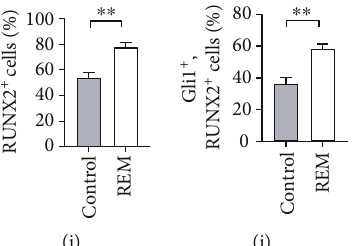
Figure 1: Gli1 + cells residing in palatal sutures involved in mechanical force-induced maxillofacial bone remodeling. (a) Experimental procedure: Gli1-LacZ mice were sacri fi ced seven days after rapid maxillary expansion (RME) treatment. Control mice were not subjected to RME and were sacri fi ced at the same time. (b) Coronal sections of maxillae of RME and control mice were stained with hematoxylin/eosin and Masson ’ s staining. Compared with that in the controls, maxillofacial sutures in RME mice were expanded, and cells residing on the nasal and oral sides of the suture had increased. Collagen in the suture was rearranged along the direction of the mechanical force. The area between two dotted lines shows the midpalatal suture. Scale bar: 100 μ m; n = 3 . (c) New bone formation was visualized using calcein; the distance between green fl uorescence lines indicates newly formed bone. Scale bar: 20 μ m; n = 3 . (d) New bone deposition rate was faster in the RME group, ∗∗∗ P < 0 : 005 ; n = 3 . (e) Micro-computed tomography (micro-CT) shows horizontal plane views of the maxillae. Scale bar: 2mm. The left panel shows magni fi ed sutures in the boxes. Scale bar: 0.5mm. (f) The distance between two fi rst molars was widen in RME mice. ∗ P < 0 : 05 ; n = 3 . (g) Immuno fl uorescence staining presents Gli1 (green) and RUNX2 (red) expression in the midpalatal suture areas of the RME group and control group. Scale bar: 100 μ m. Regions in boxes are magni fi ed in the right panel: “ N ” indicates the nasal side of the midpalatal suture and “ O ” indicates the oral side. Scale bar: 50 μ m. (h) Proportions of Gli1 + cells increased on nasal and oral sides and midpalatal suture in RME mice. ∗∗ P < 0 : 01 ; n = 3 . (i) Proportion of RUNX2 + cells in midpalatal suture increased in RME mice. ∗∗ P < 0 : 01 ; n = 3 . (j) Gli1 + and RUNX2 + cells increased in sutures of RME mice. ∗∗ P < 0 : 01 ; n = 3